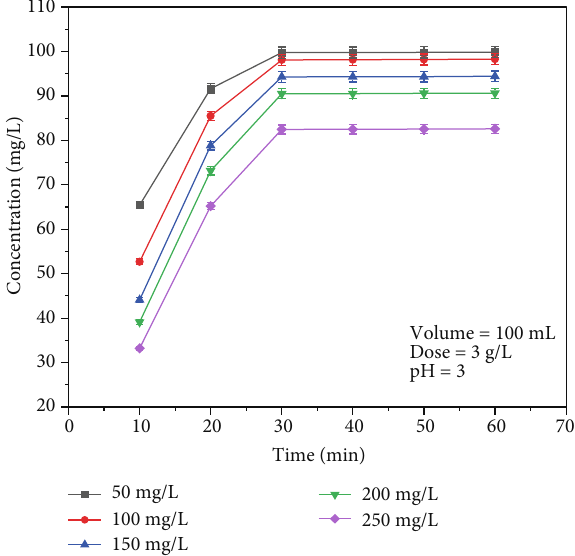
Figure 10: E ff ect of contact time on ARS dye removal.